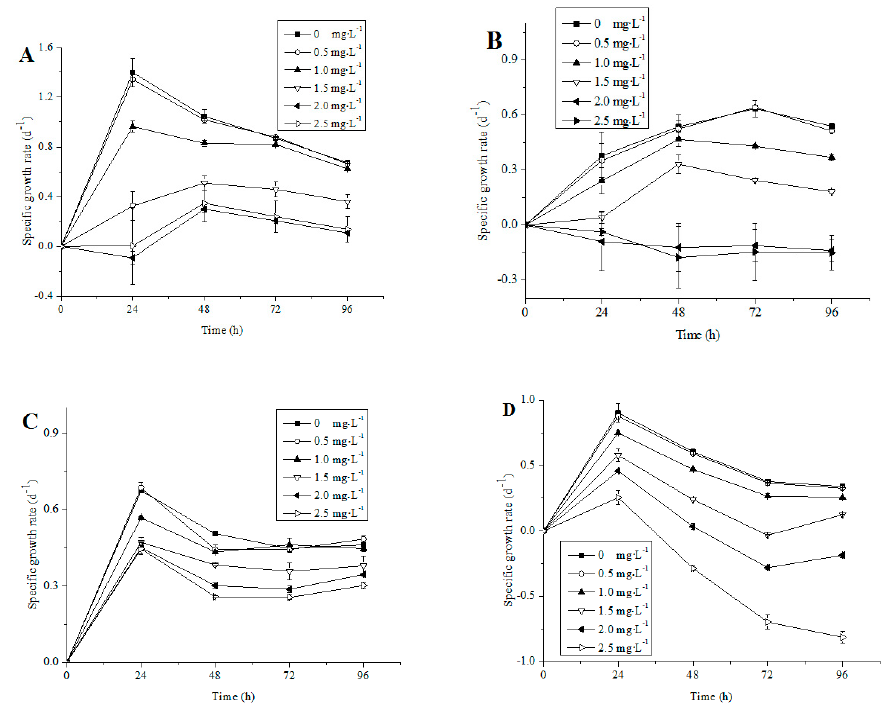
Figure 2. Growth of ( A ) A. acicularis ; ( B ) C. minutus ; ( C ) C. vulgaris and ( D ) S. quadriauda , exposed to different NP concentrations at the end of 0, 24, 48, 72 and 96 h (mean and standard deviation of three replicates were shown).